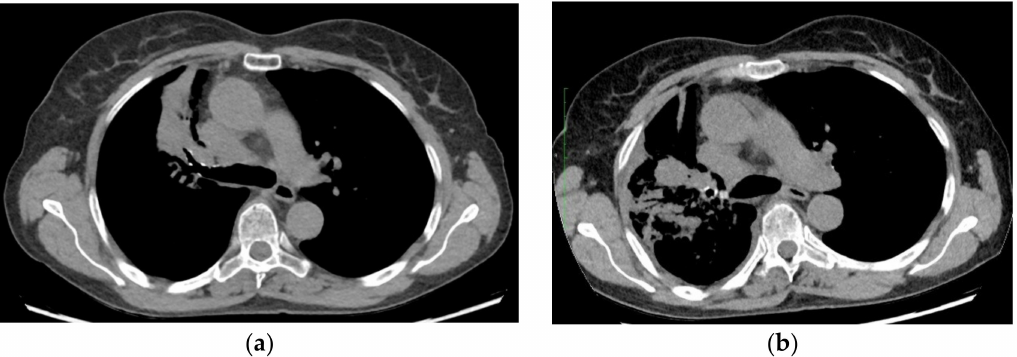
Figure 1. Computed tomography (CT) images of the lung ( a ) CT scan 1 month after first osimertinib administration ( b ) CT scan 3 months after first osimertinib